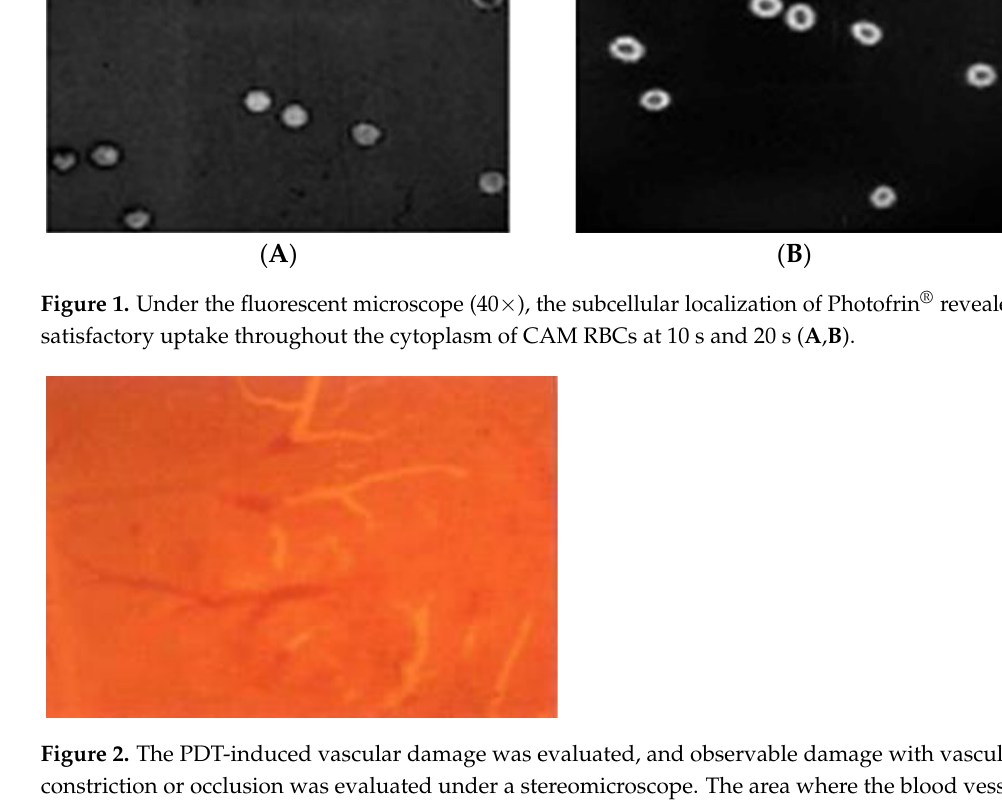
Figure 2. The PDT-induced vascular damage was evaluated, and observable damage with vascular constriction or occlusion was evaluated under a stereomicroscope. The area where the blood vessel color turns white represents the vascular damage induced by PDT (right-hand side). In contrast, the area where the blood vessel color remains unchanged as a control represents the vascular tissue not damaged by PDT (left-hand side).